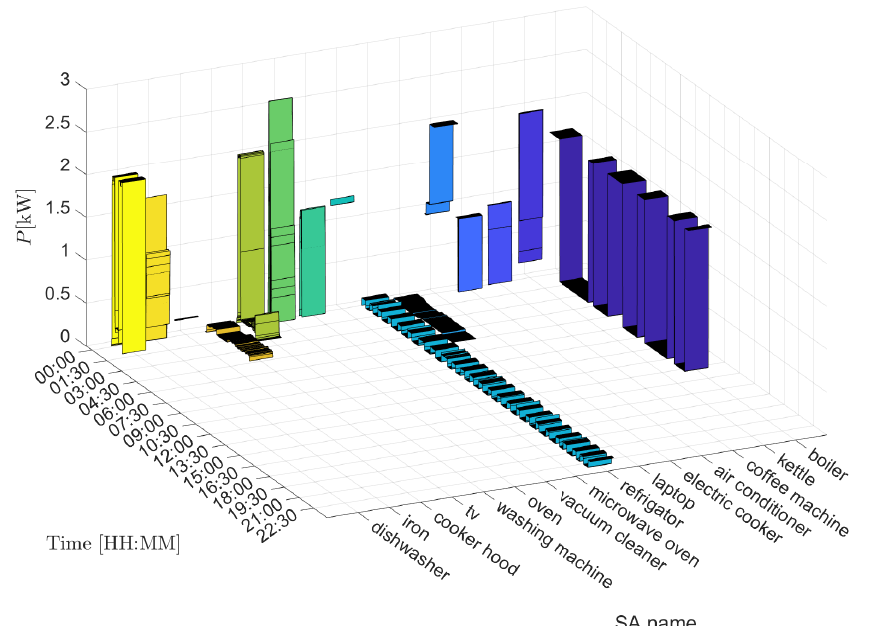
Figure 5. Profiles of